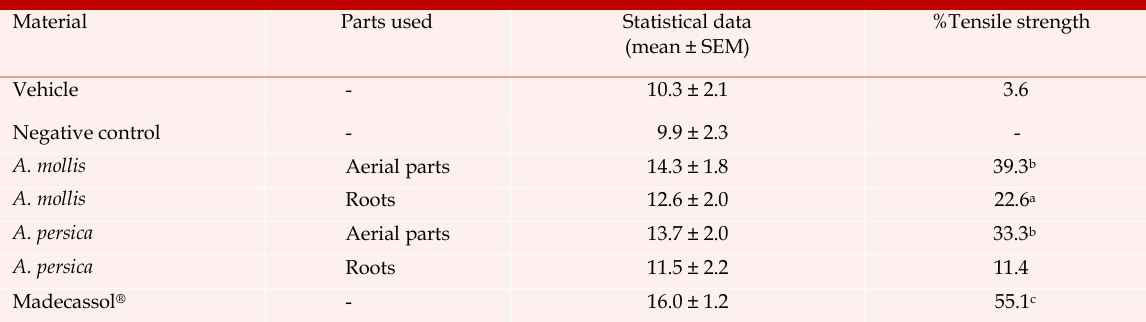
Effects of the extracts of A. mollis and A. persica on linear incision wound model